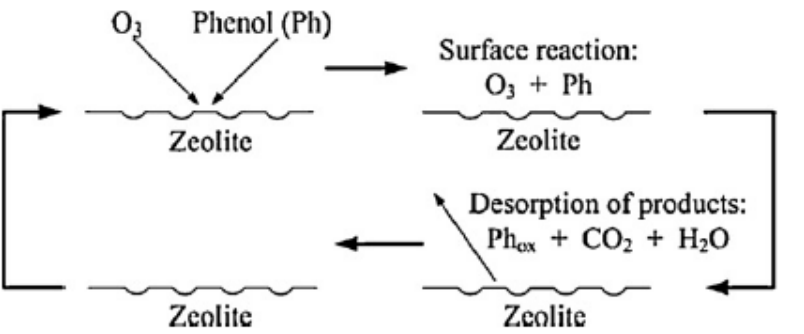
Figure 21. Schematic mechanism for removal of phenol during zeolite enhanced ozonation. Repro- duced from Ref. [4]. Copyright 2010 Elsevier.